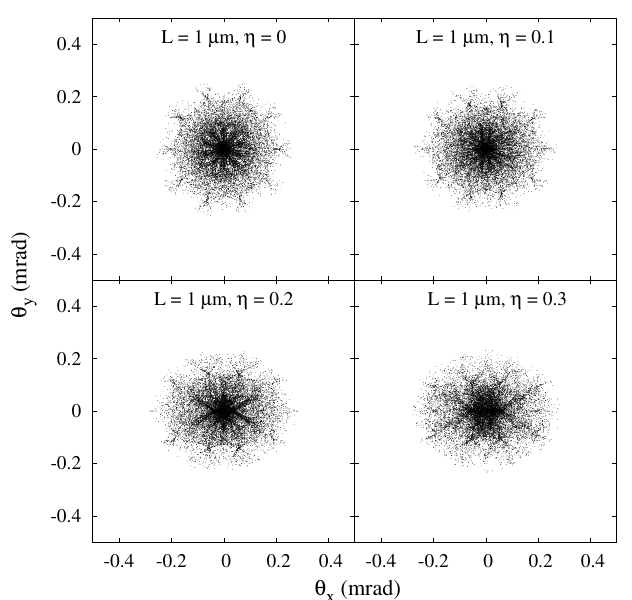
Figure 4. The angular distributions of protons channeled in the radially deformed DWNTs(10, 0)@(5, 0) under different radial strains: (left top) η = 0; (right top) η = 0.1; (left down) η = 0.2; (right down) η = 0.3, respectively. The proton energy is E = 1 GeV and nanotube length is L = 1 µ m.